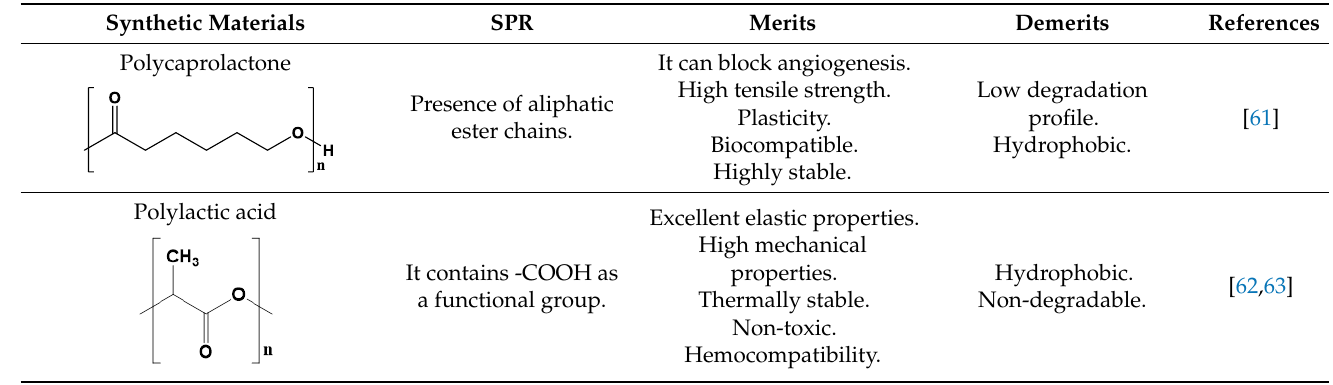
Table 2. Synthetic materials used for preparing 3D scaffolds.